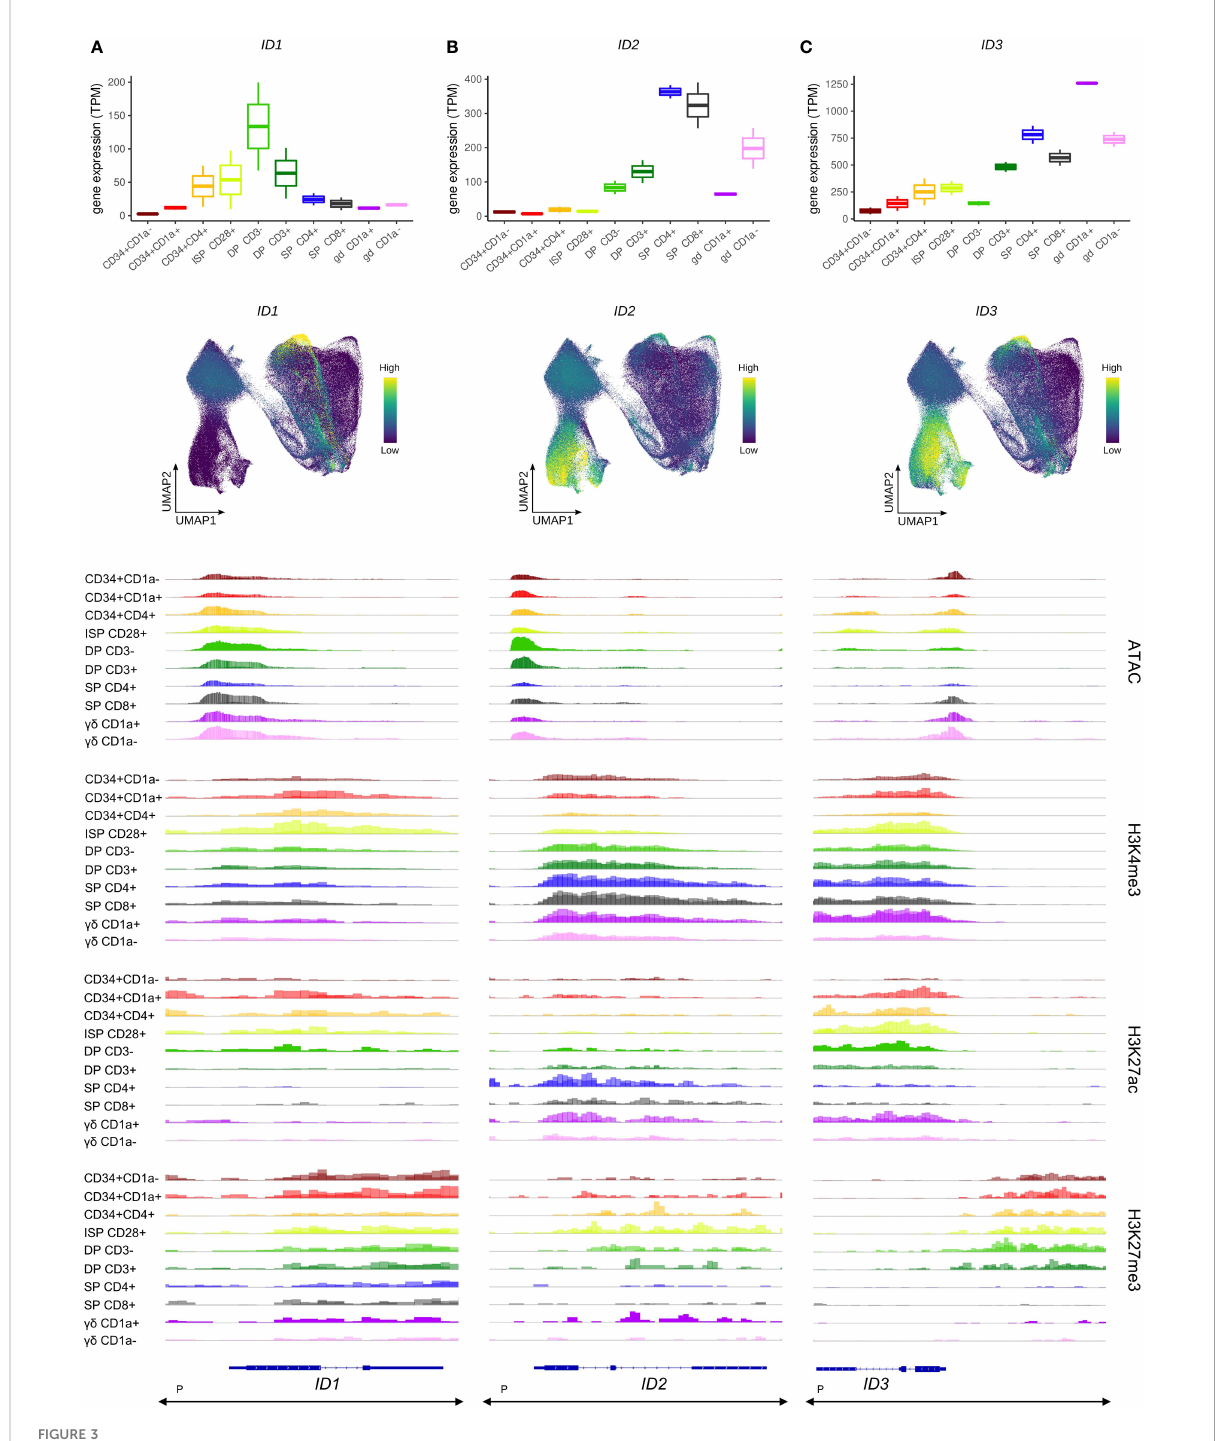
FIGURE 3 Transcription of ID protein encoding genes in developing human thymocytes. (A) Transcript levels of ID1 according to bulk RNA-seq (top) and single cell data (middle), and epigenetic pro fi le at the ID1 gene locus. (B) Transcript levels of ID2 according to bulk RNA-seq (top) and single cell data (middle), and epigenetic pro fi le at the ID2 gene locus. (C) Transcript levels of ID3 according to bulk RNA-seq (top) and single cell data (middle), and epigenetic pro fi le at the ID3 gene locus. Locations of promoters (P) for all three genes was retrieved from the Ensembl Regulatory Build and was found to span the entire locus as indicated below the gene structure. UMAP visualizations were generated using imputed